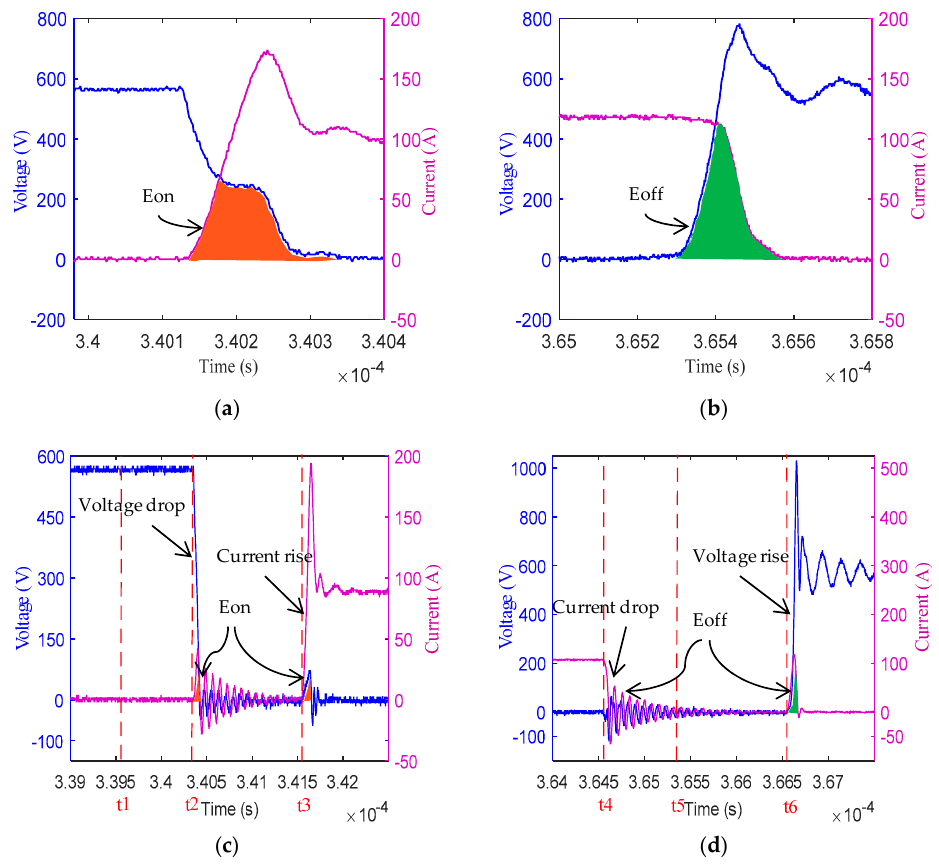
Figure 7. Experimental comparison results of IGBT V-I curves in different double pulse test ( a ) IGBT turn-on transition in the common DPT; ( b ) IGBT turn-off transition in the common DPT; ( c ) IGBT turn-on transition in DPT with hybrid switches; and, ( d ) IGBT turn-off transition in DPT with hybrid switches.